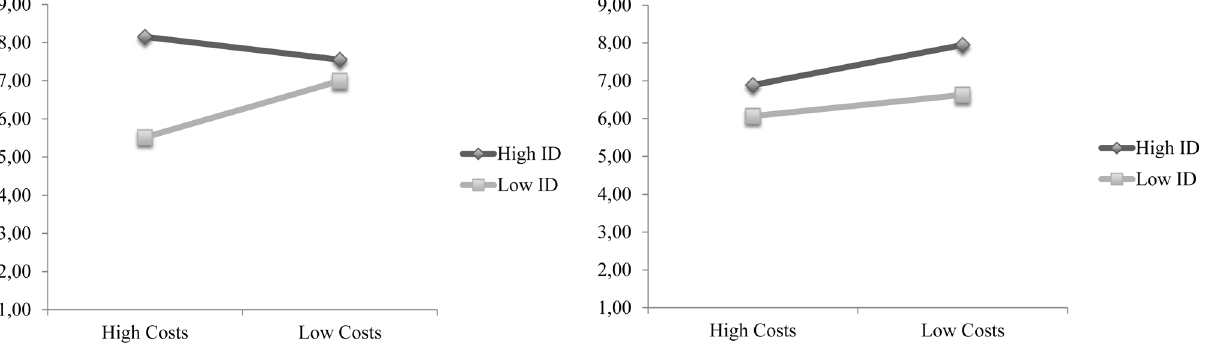
Figure 1. Three-way interaction of identification, costs, and trust on willingness to participate in public policy making. Left: High trust; Right: Low